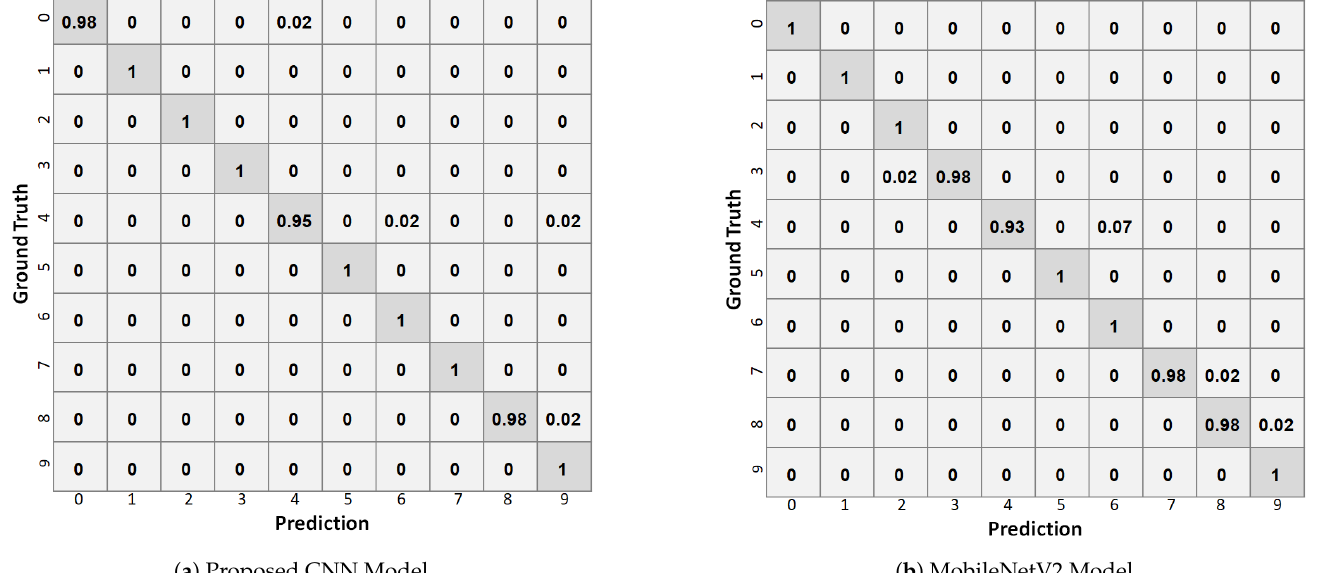
Figure 8. Confusion matrix of both the models on test dataset.